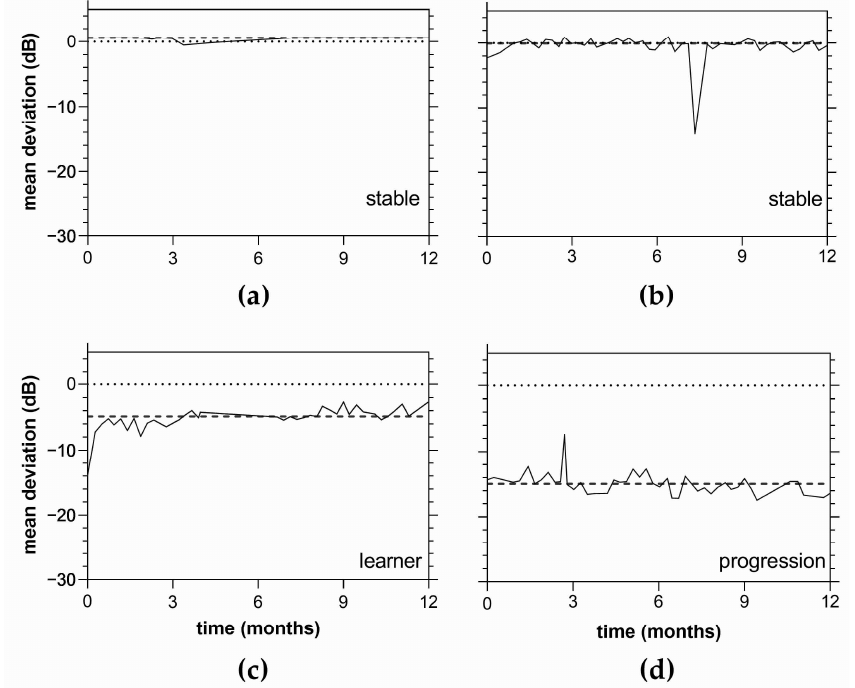
Figure 4. Example mean deviation (MD) trends over 12 months of visual field telemedicine for 4 participants: ( a ) stable data with no learning or fluctuation events; ( b ) stable with a single fluctuation event; ( c ) learning effect with fluctuation; ( d ) one case of progression on the MRFh (Progressor 1, Figure 9). The dashed lines indicate the median of all data points. Although the progression involves only a small change (approximately 2 dB), note how the data consistently falls under the median line towards the end of the monitoring period (right side of ( d )).